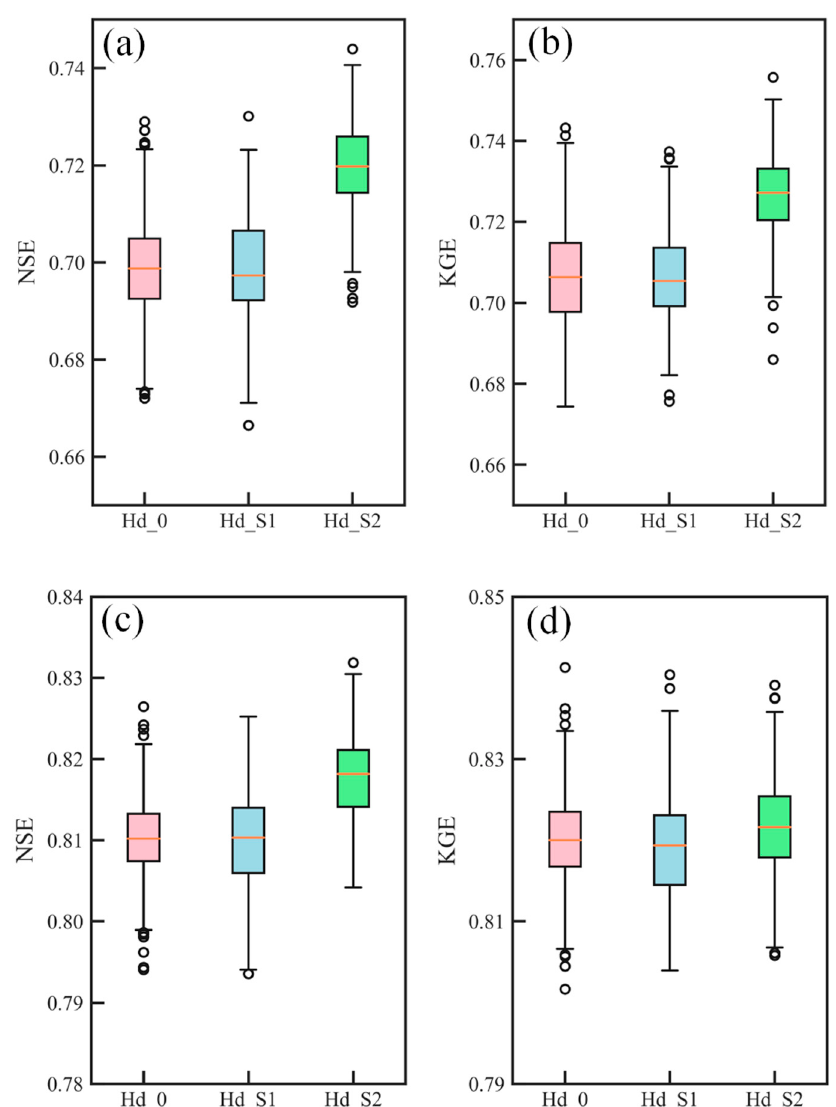
Figure 10. Performance for Waizhou station ( a , b ) and Xiajiang station ( c , d ) at the Ganjiang River catchment in terms of NSE and KGE using parameter sets from the donor catchment. The boxplots represent the variation due to 2000 simulations.